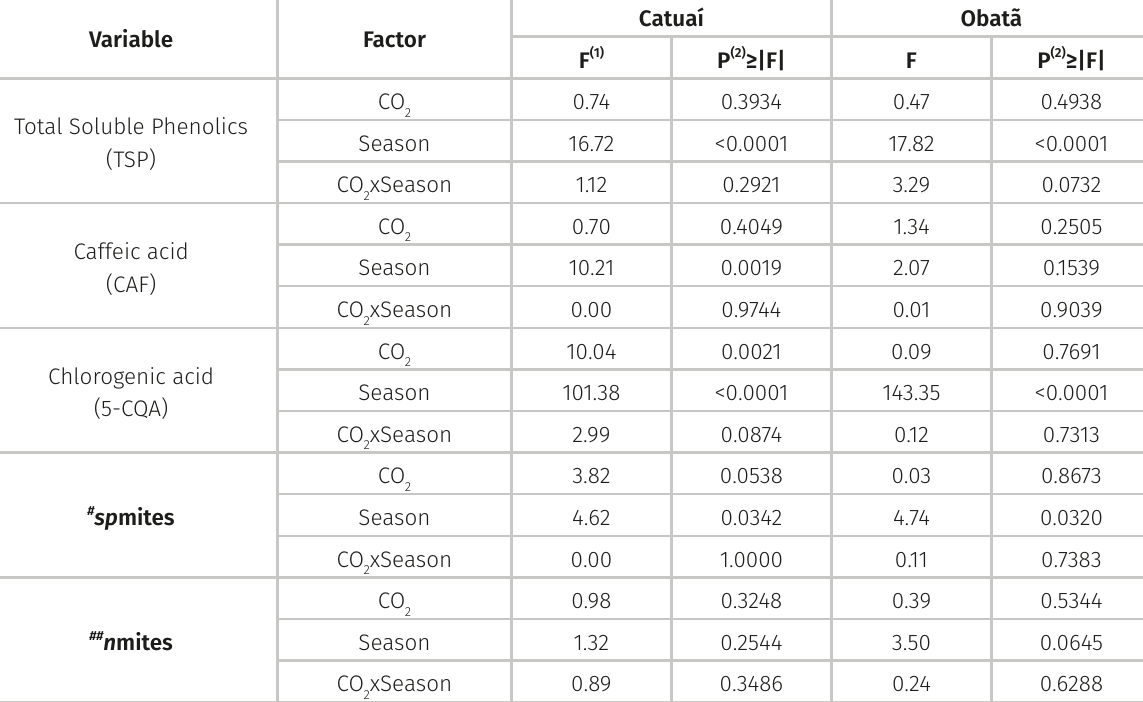
Table I. Variance analysis of TSP, CAF, 5-CQA, mite diversity ( sp mites) and mite population ( n mites), in two coffee cultivars (Catuaí and Obatã), with two levels of [CO